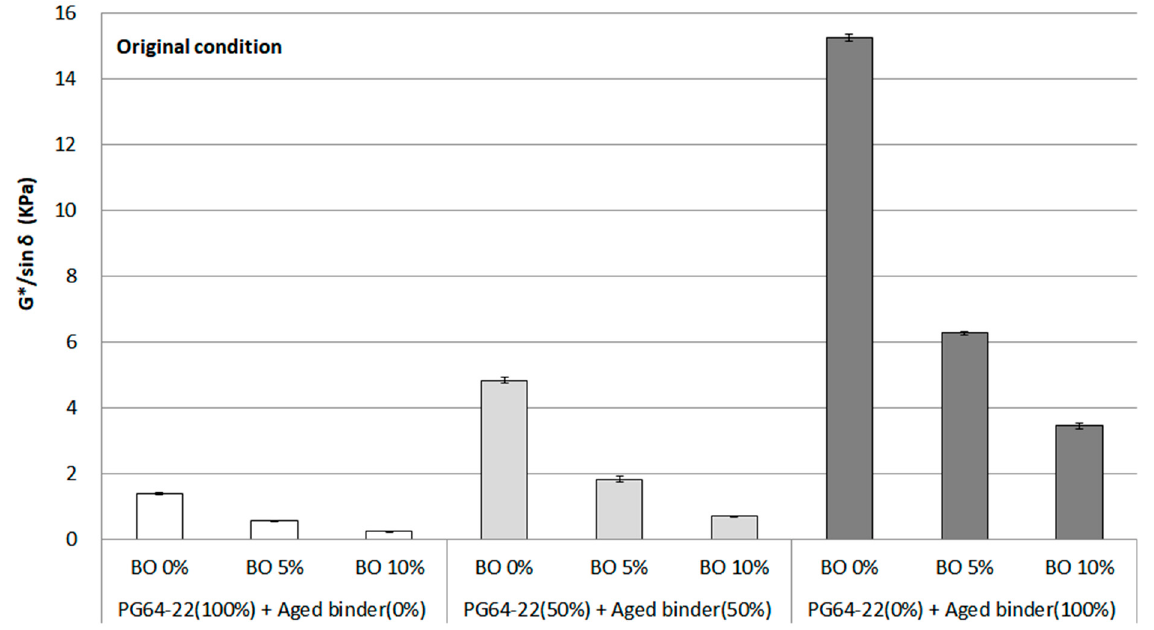
Figure 5. G*/sin δ of each asphalt binder containing the base oil for original condition.